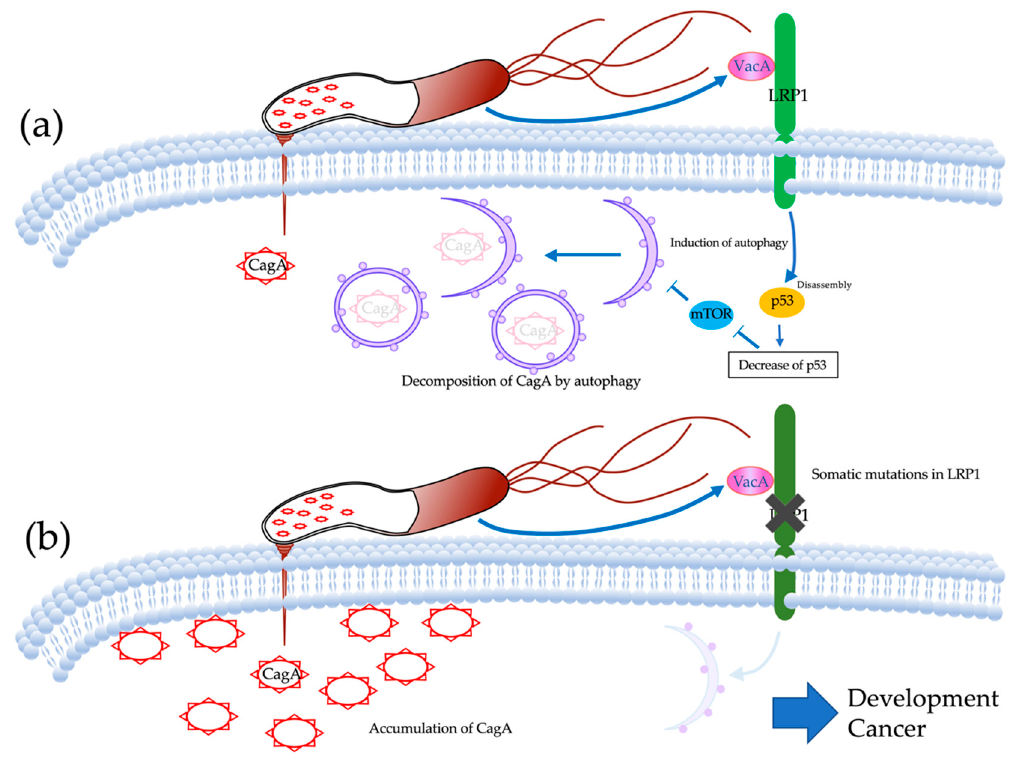
Figure 5. The mechanism of developing gastric cancers by LRP1 mutations. ( a ) CagA is injected into epithelial cells by the type IV secretion system, but binding of VacA and LRP1 induces autophagy and CagA is degraded. ( b ) LRP1 mutations damage the intake of VacA into gastric epithelial cells, inhibit autophagy of CagA, and then develop gastric cancers.